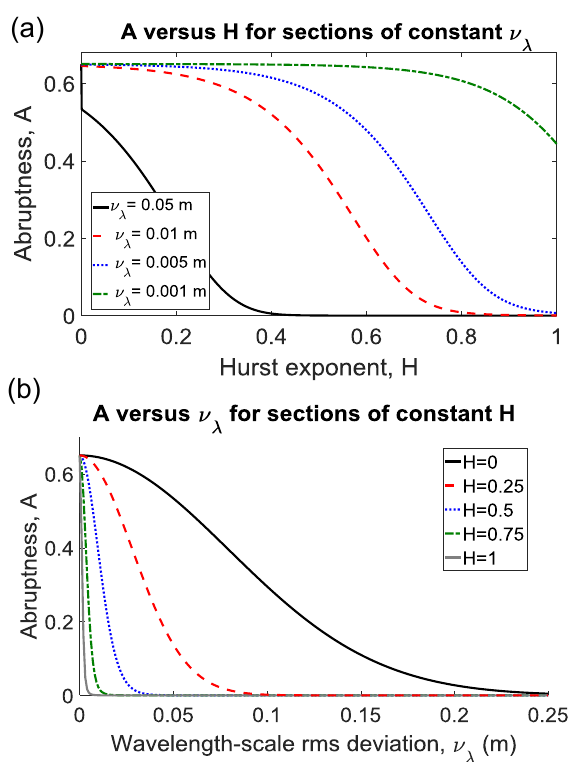
Figure 5. Parametric dependence of the self-affine radar scattering model. (a) Abruptness, A , as a function of the Hurst exponent, H , for sections of constant wavelength-scale rms deviation, ν λ . (b) A as a function of ν λ for sections of constant of H . The plots illustrate primary dependence for A upon H and secondary dependence for A upon ν λ . High A is suppressed for high H except in the case of exceptionally small ν λ